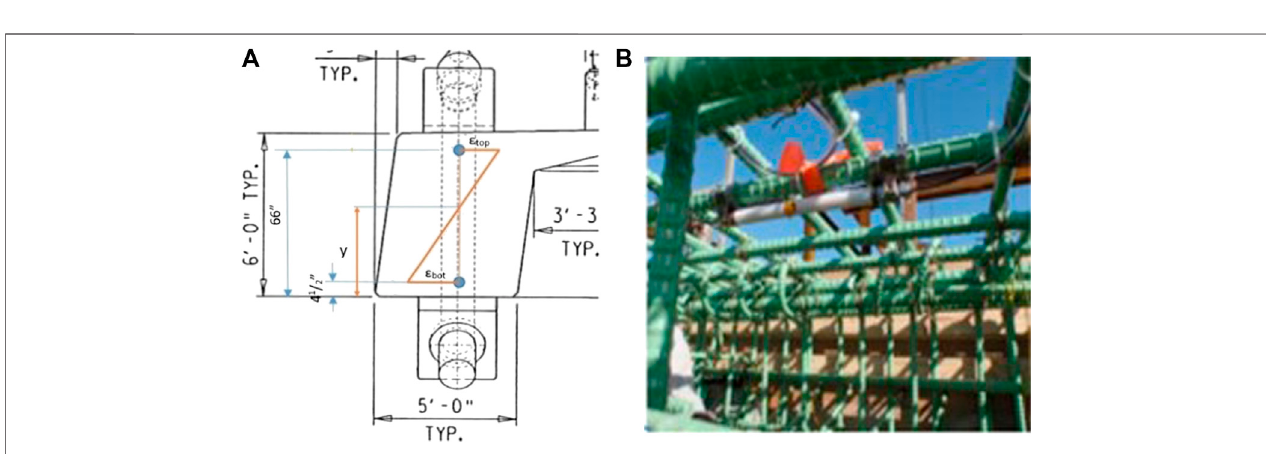
FIGURE3 | Edge girder ofIRIB (A) cross-section including strain sensors location, where ε top and ε bot refer to thestrain measured at thetop and thebottom ofthe section, respectively, and the position of N.A., as distance y from the bottom of the girder, assuming linear strain development (B) photograph from the installation of sensor during